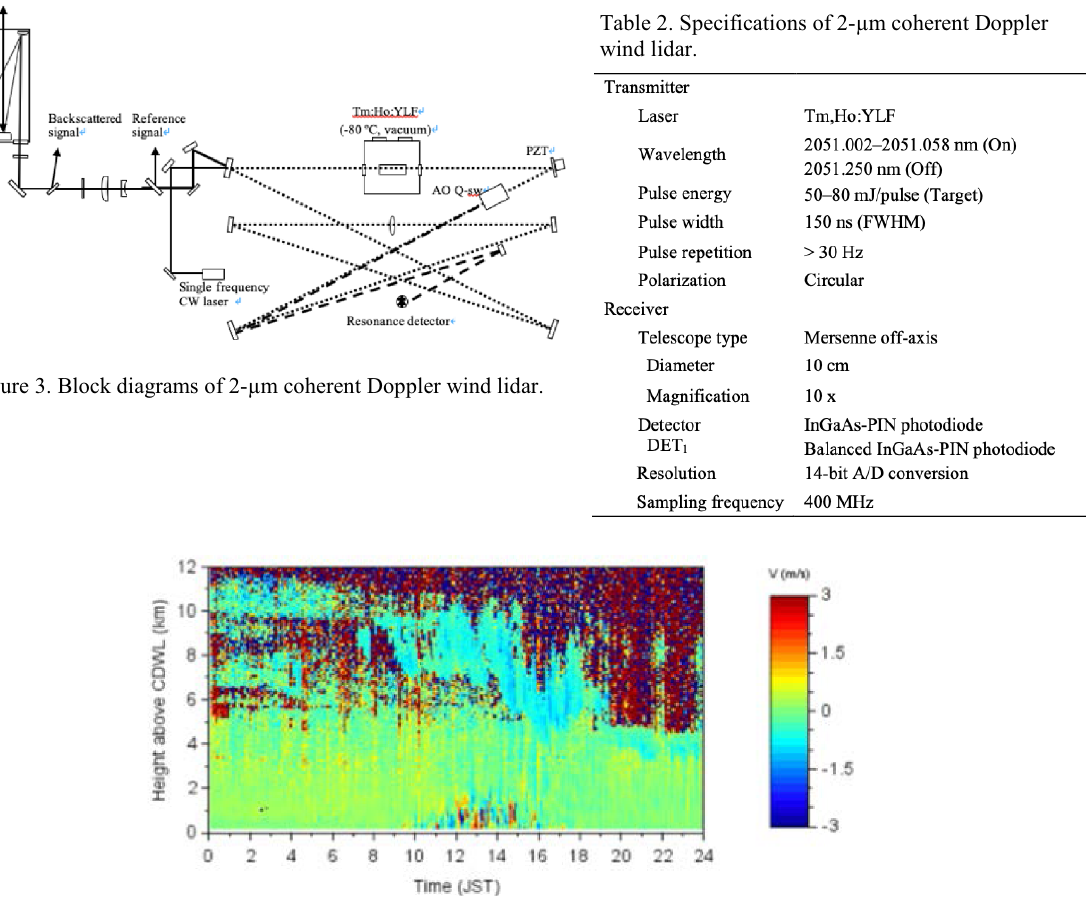
Figure 4. Temporal variation of vertical wind speed and SNR observed by 2-μm coherent DWL on 27 Mach,